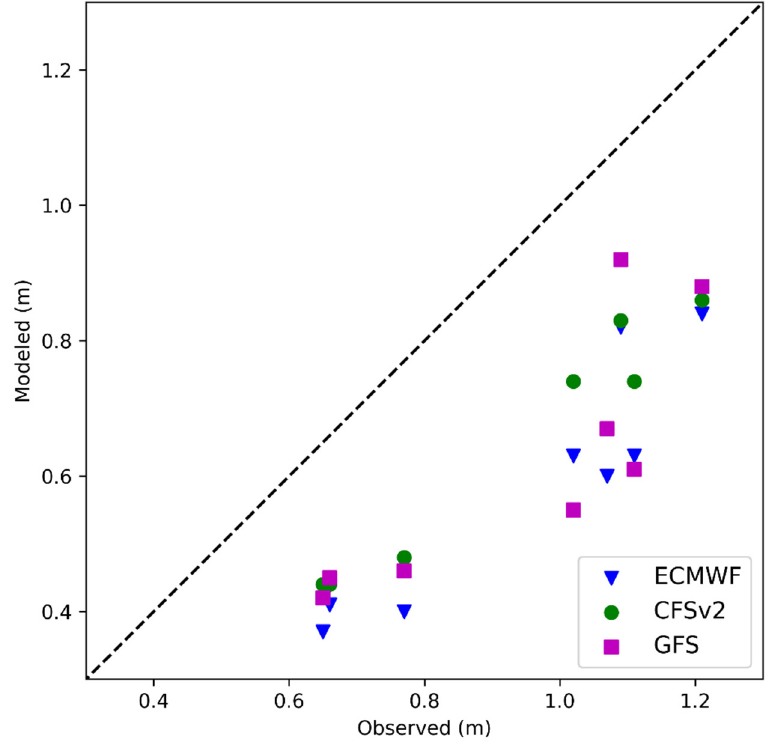
Figure 9. Scatter plot of maximum TWL.